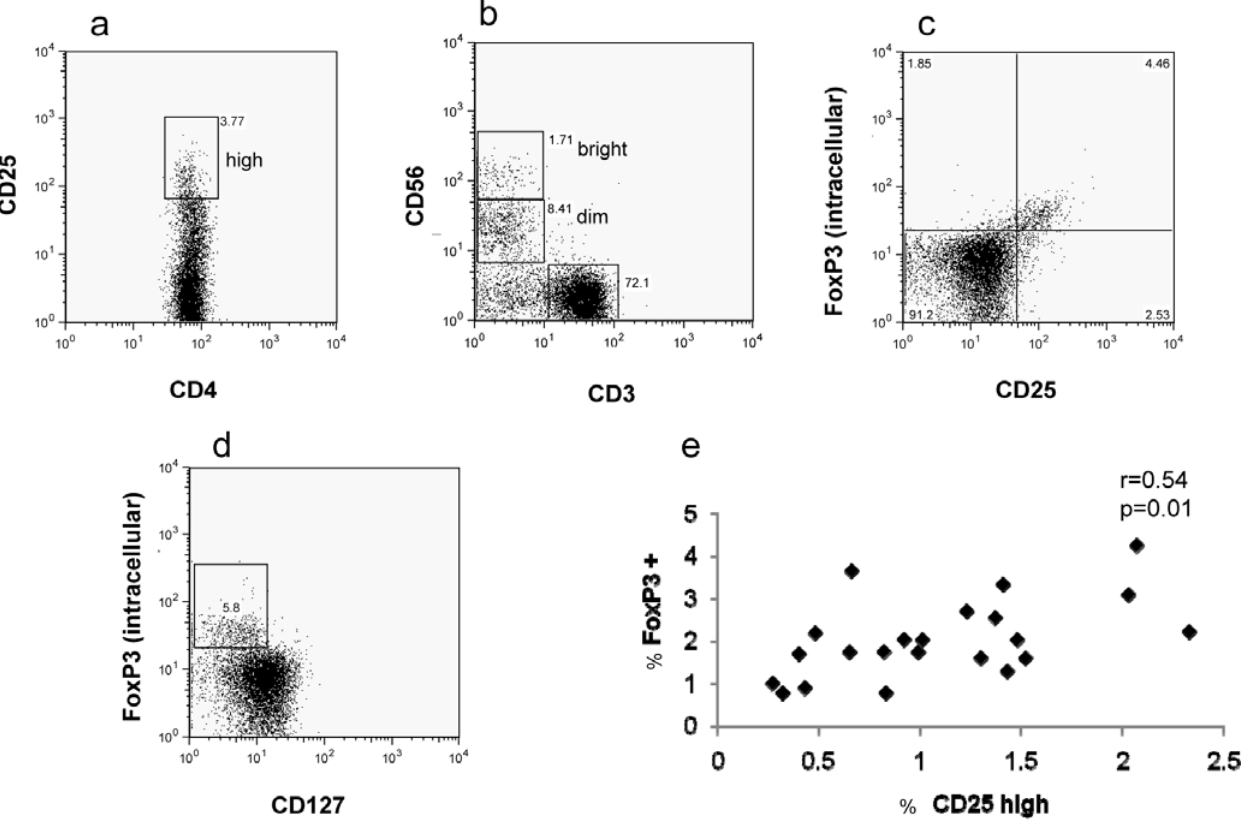
Figure 4. Characterisation of regulatory T cells and NK cells. Ex-vivo PBMC were stained for surface CD4, CD25 and CD127, and intracellularly for FoxP3. Typical dot plots show (a) the distribution of CD25 determining CD25 high status, (b) the distribution of CD56 on CD3 negative (NK) cells determining CD56 dim and CD56 bright status, (c) that the majority of FoxP3 + cells are CD25 high , and (d) that the FoxP3 + cells are predominantly CD127 2 [28]. (e) A correlation was demonstrated between CD25 high and FoxP3